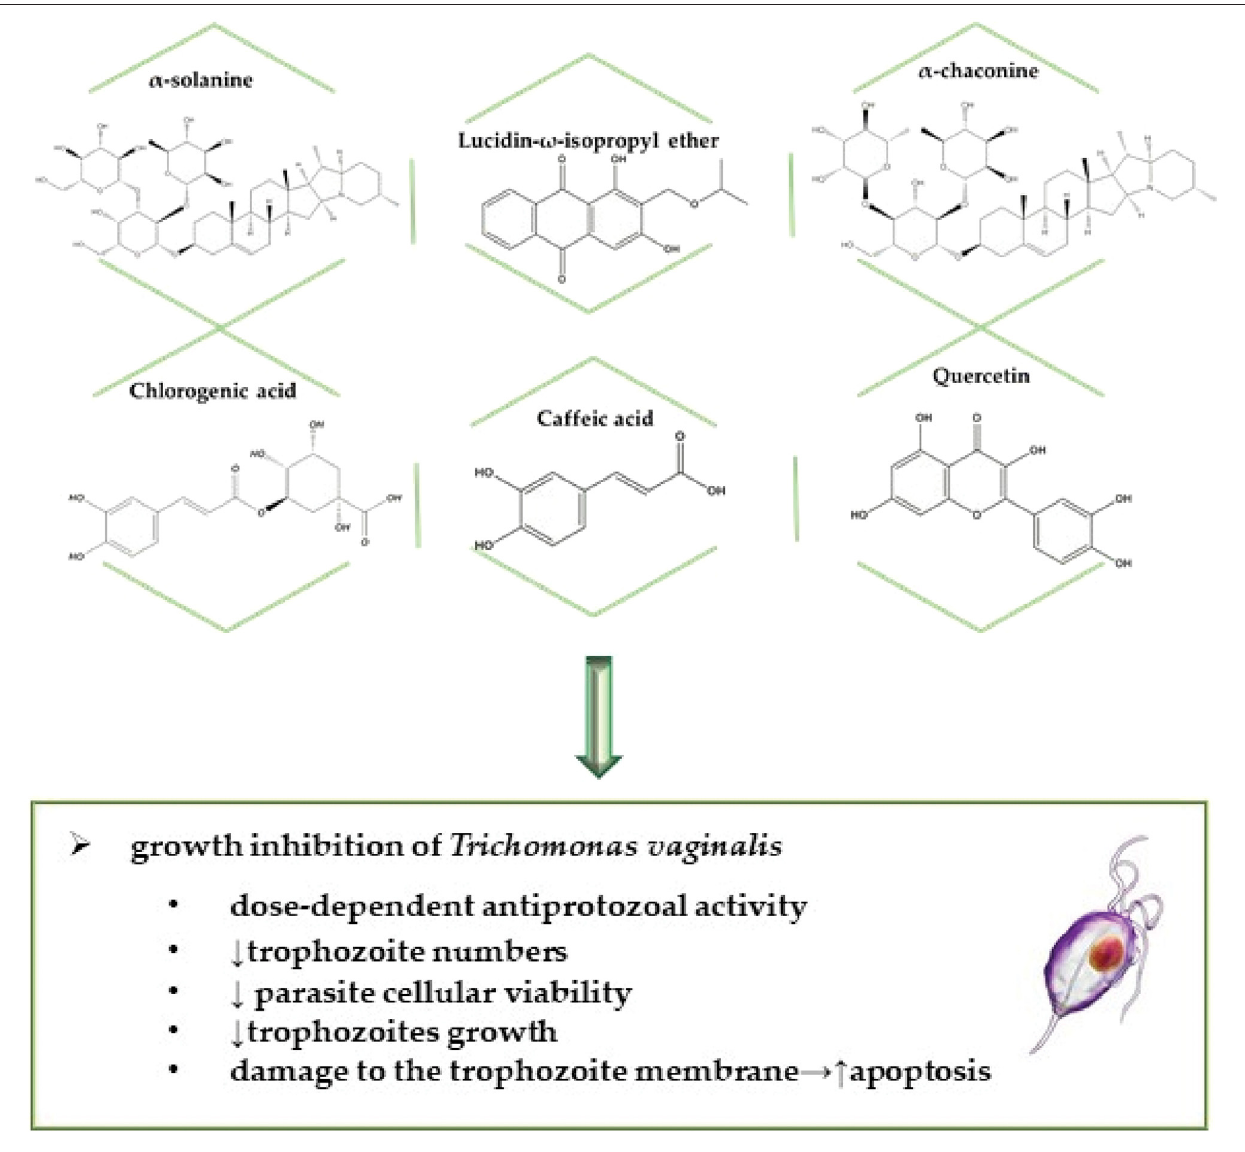
FIGURE 5 | Selected bioactive compounds against STDs caused by parasites, speci fi cally by protozoa.